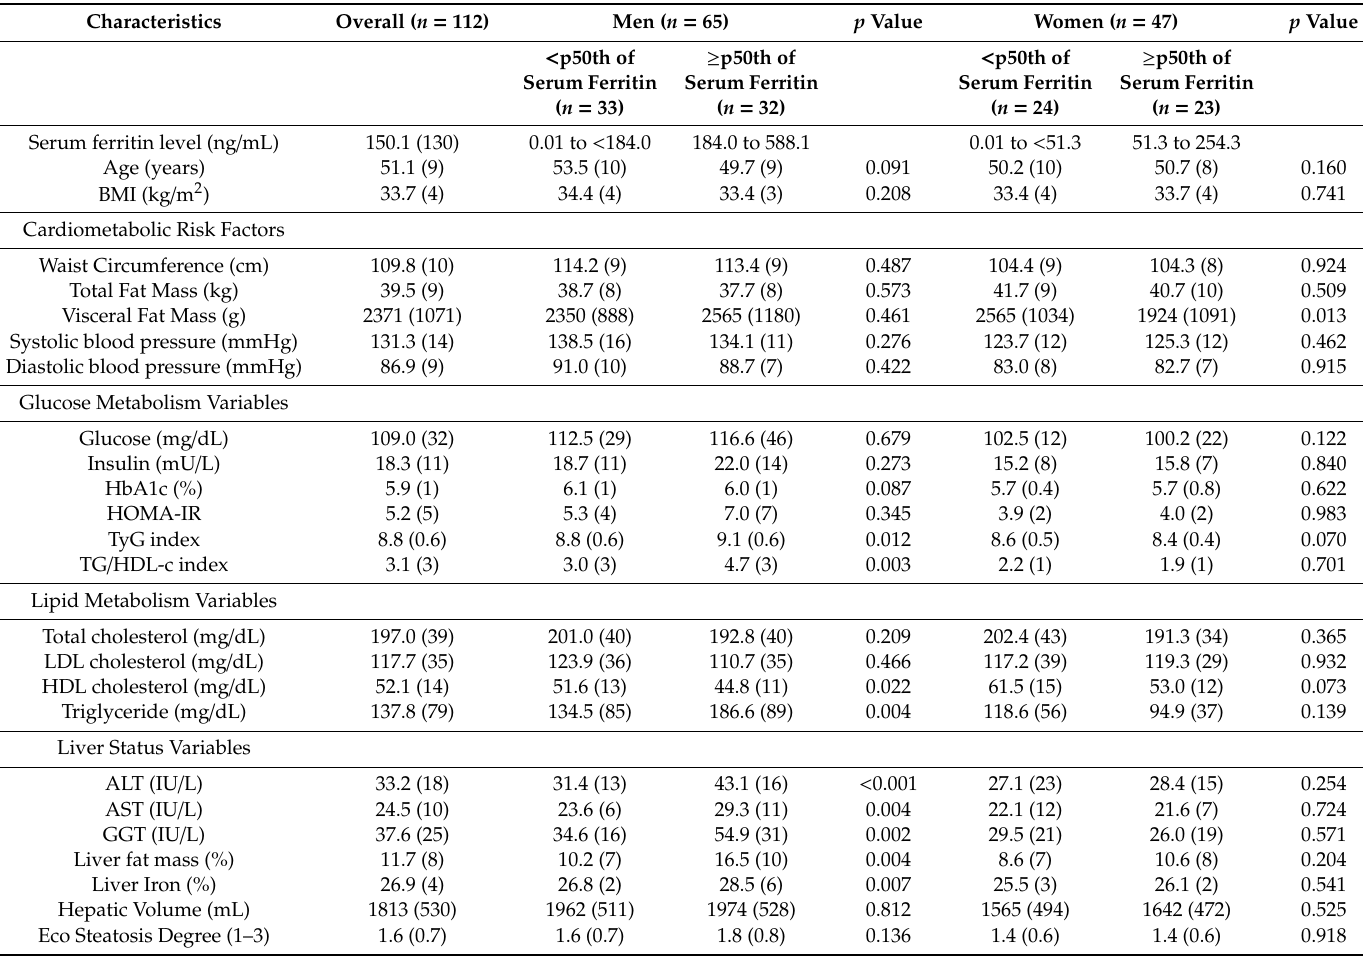
Table A1. Baseline characteristics of participants according to p50th of serum ferritin for men and women, respectively.